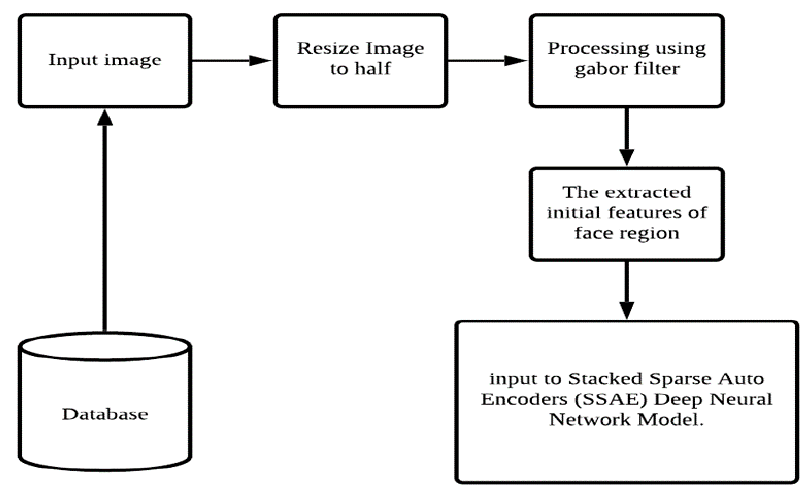
Figure 4. Structure of hybrid deep neural model.